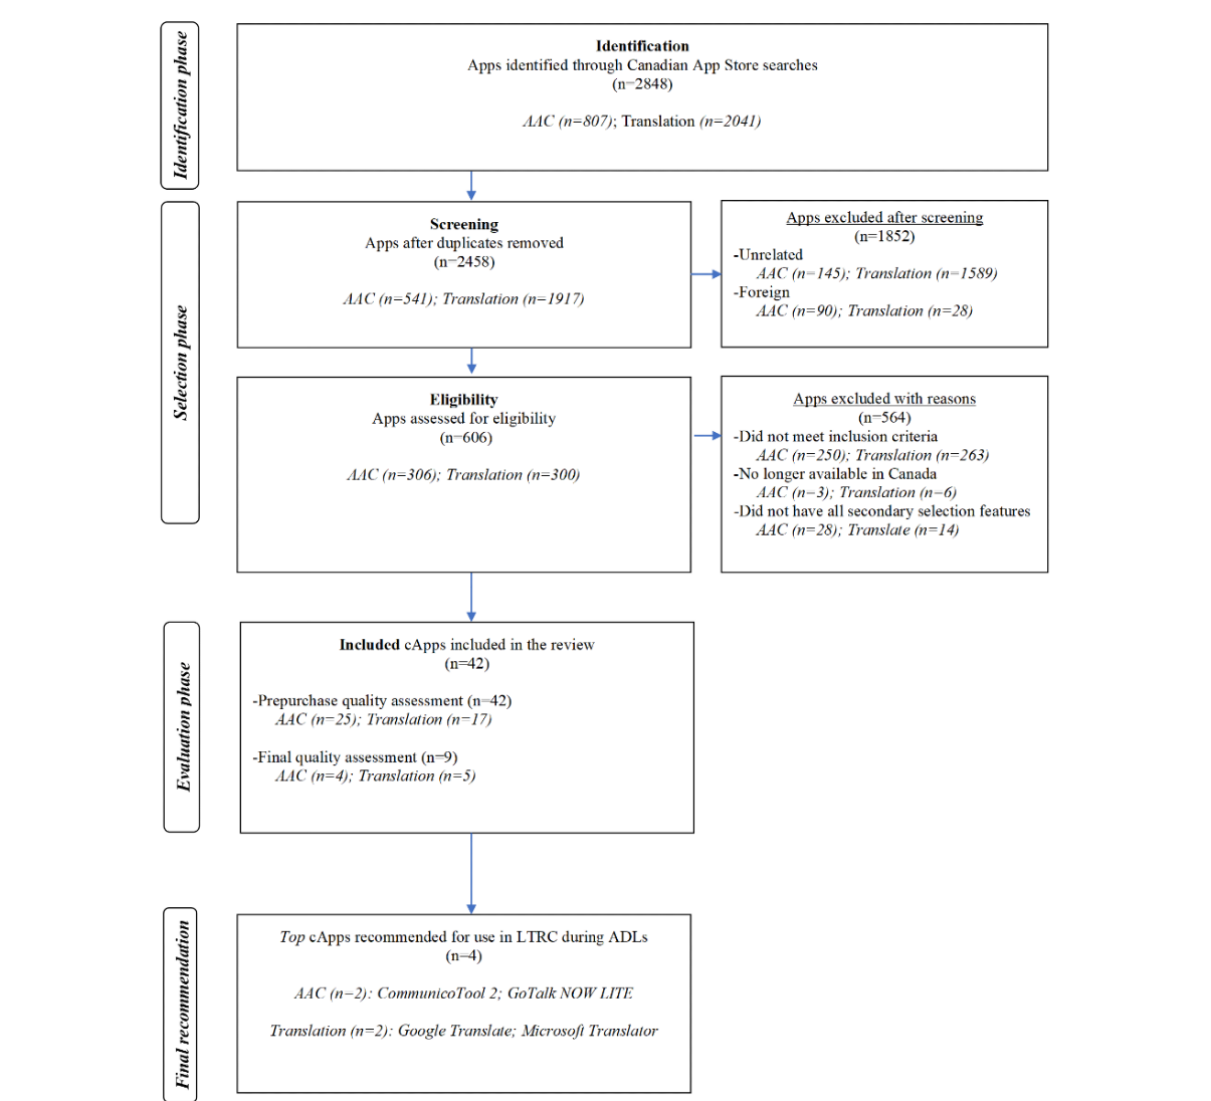
Figure 3. Flow diagram summarizing the results of the identification, selection, evaluation, and final recommendation phases involved in the 2017 communication app replication review. The presentation of results was guided by the Preferred Reporting Items for Systematic Reviews and